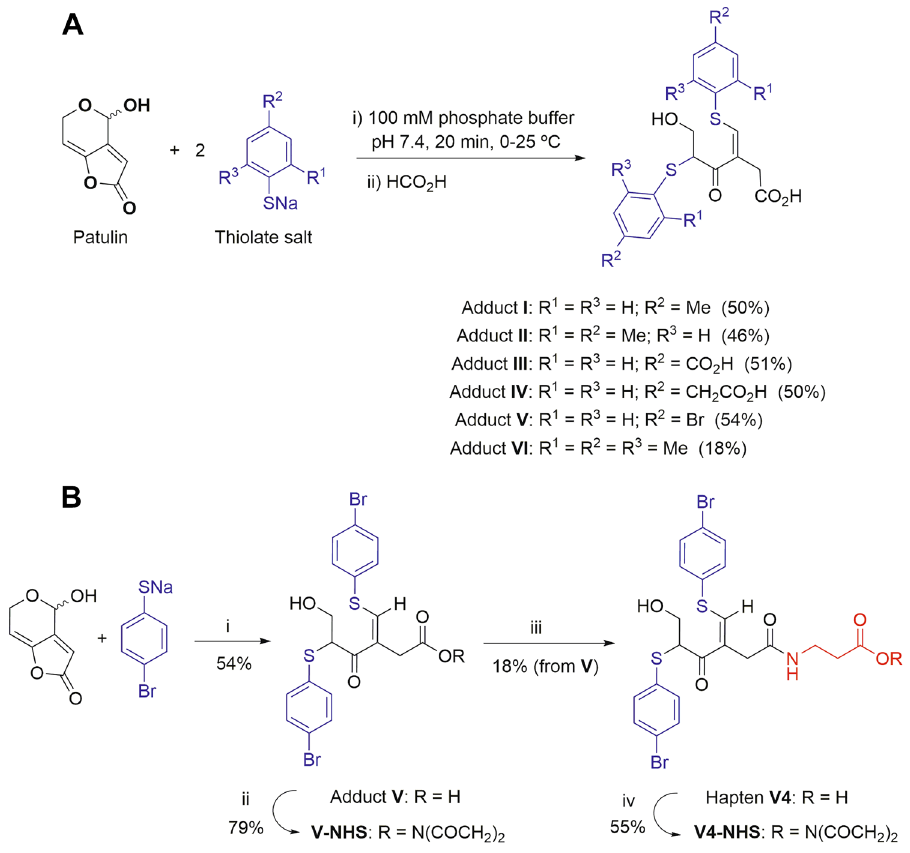
Figure 5. ( A ) Reaction of patulin with the studied aromatic thiols and structures of the major adducts that are formed. The coloured fragments correspond to the thiolate framework incorporated into the adduct structure. The yields (in parentheses) were calculated after chromatographic purification in order to characterize the adducts by spectroscopic methods; however, with no workup the reactions are nearly quantitative. ( B ) Synthesis and activation of adduct V and hapten V4 . Reagents and conditions: (i) 100 mM sodium phosphate buffer, pH 7.4, 0 °C, 20 min; (ii) EDC·HCl, NHS, CH 2 Cl 2 , − 20 °C, 1 h; (iii) β-alanine, MeCN/H 2 O (1:1), from 0 °C to